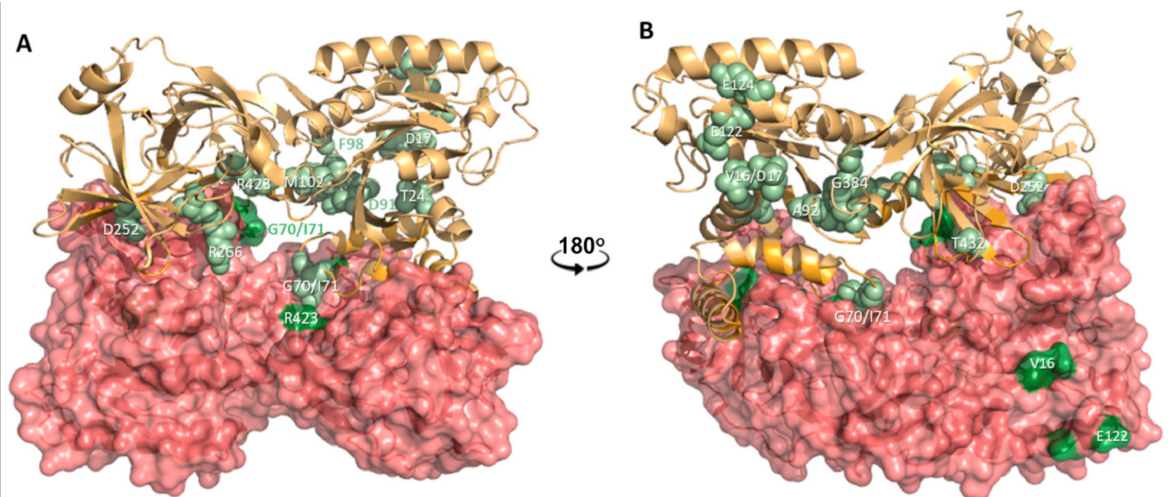
Figure 2. Cartoon representation of the crystallographic eEF1A2 dimer present in the asymmetric cell unit [59], with each monomer in a different color and one monomer enveloped in a van der Waals surface. Views in ( A , B ) are related by a 180 ◦ rotation about the Y-axis. The amino acids enumerated in Table 2 because of their known involvement in genetic disorders are colored in green and labeled in one-character notation. Note that the majority of these amino acids cluster at the dimerization interface and also between domains I and III of each